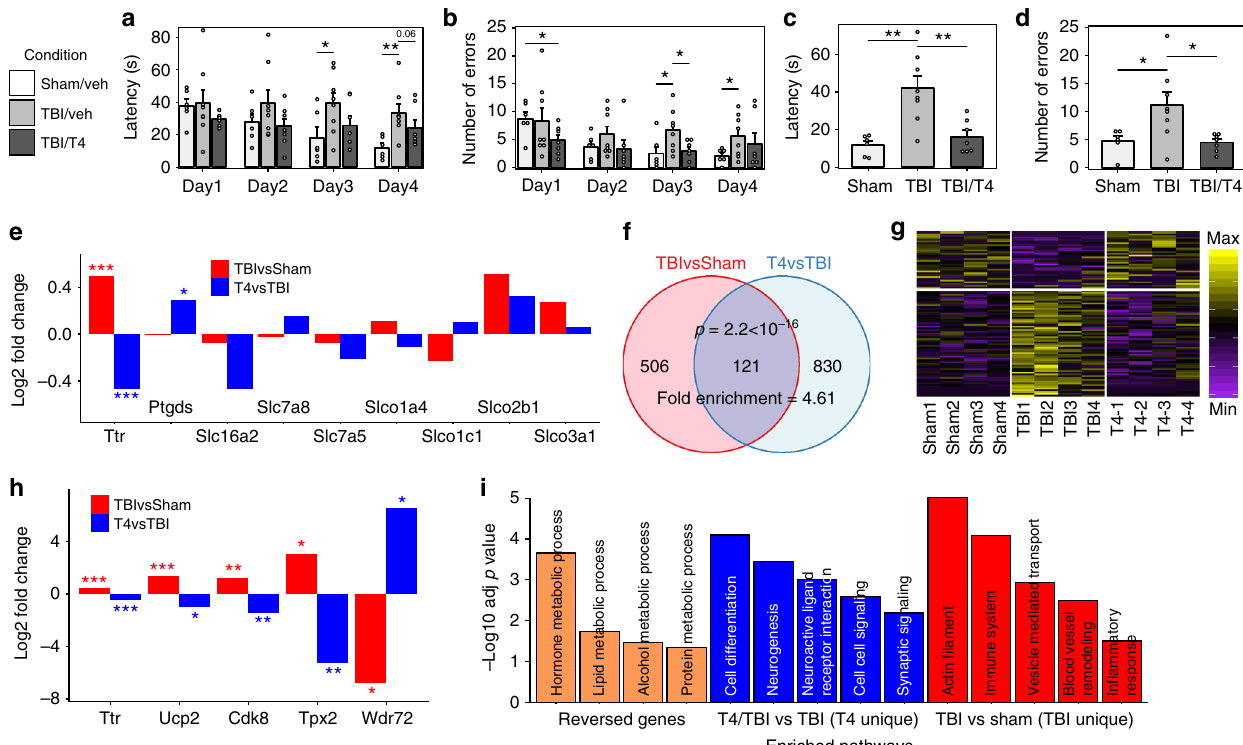
Fig. 9 Validation of T4 treatment effects. a , b T4 treatment effects on learning through measurement of latency ( a ) and number of errors ( b ). c , d T4 treatment improves memory through measurement of latency ( c ) and number of errors ( d ) in Barnes Maze test. Bargraphs display mean values with error bars representing the standard error of the mean. Two-sided t -test was used to determine signi fi cance. e Ttr is the primary thyroid hormone transporter responsive to TBI and T4 treatment compared to other known transporters. f – h Gene expression pro fi les of T4 treatment experiments. f TBI and T4 treatment show signi fi cant overlap in DEGs. Sign fi cance in overlap was determined using Fisher ’ s exact test. g Heatmap showing T4 reversed the expression patterns of 93 TBI-affected genes. h Examples of TBI genes reversed by T4. Signi fi cance of DEGs between the two conditions in e and h is determined by the negative binomial model, and the log2 fold change between two conditions based on the average gene expression values of the two groups was plotted on the y -axis. i Enriched pathways among the 93 TBI DEGs reversed by T4, pathways unique to T4 treatment (T4/TBIvsTBI) and those unique to TBI (TBIvsSham). Enrichment of pathways were determined using Fisher ’ s exact test with Bonferroni corrected p values used for